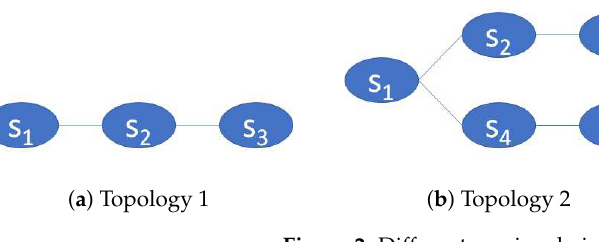
Figure 2. Different service chain